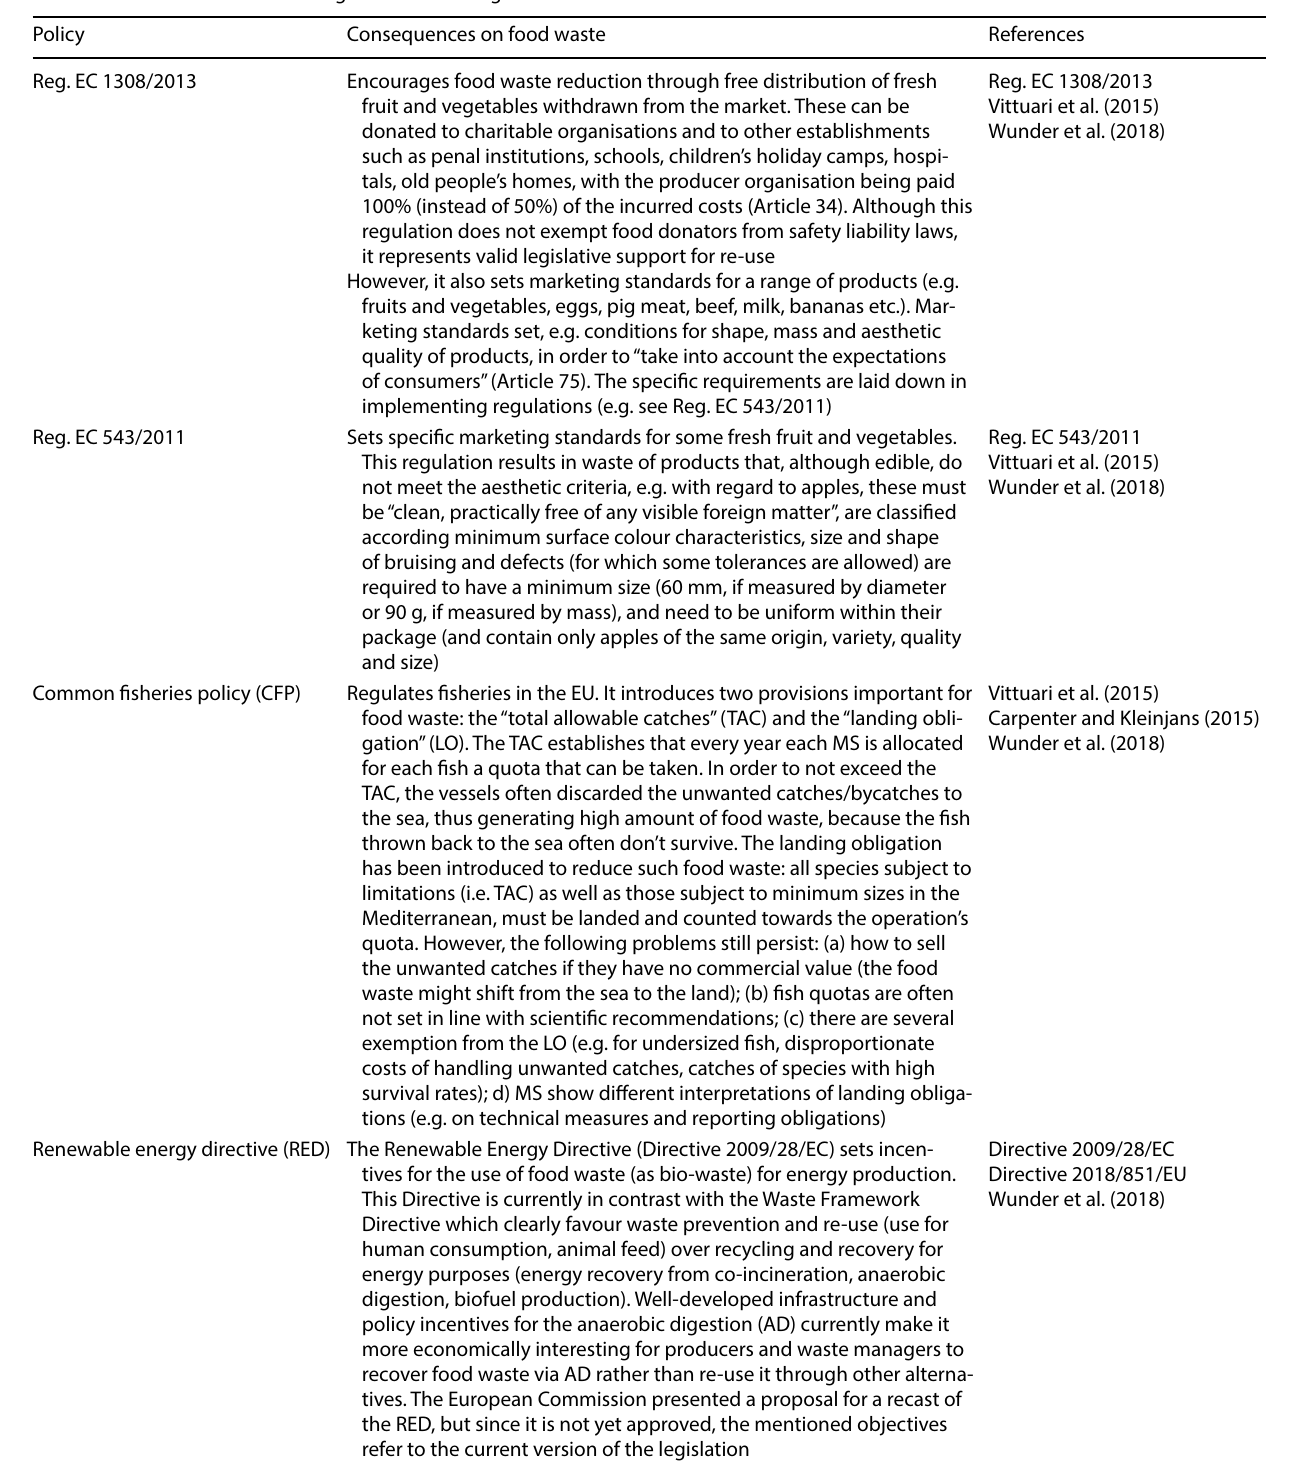
Table 4 Other EU directives and legislations affecting food